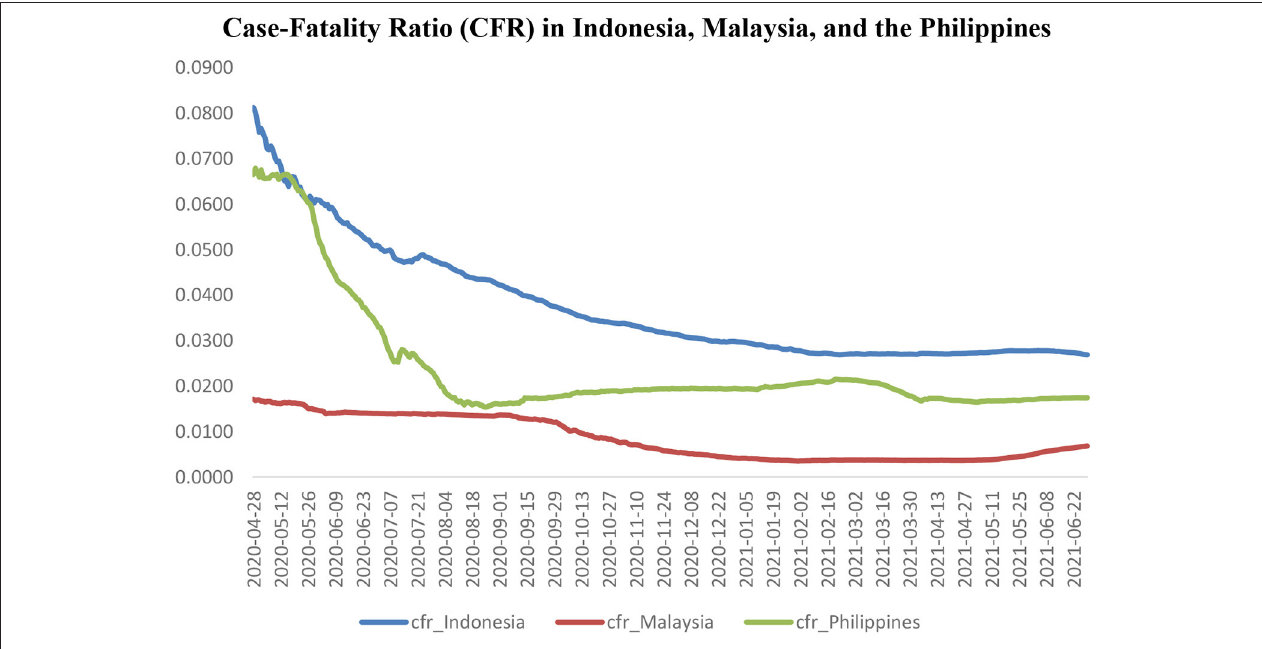
FIGURE 1 | Case-Fatality Ratio (CFR) in Indonesia, Malaysia, and the Philippines.